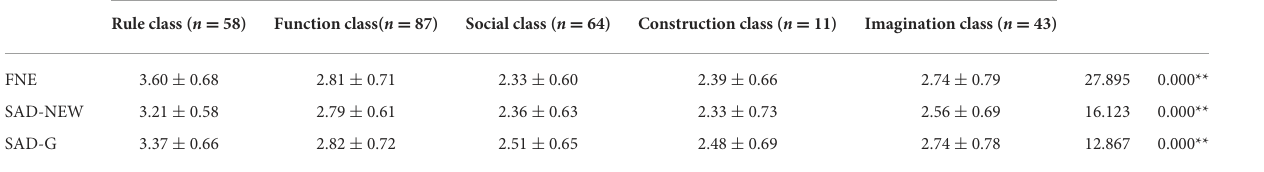
TABLE 7 Correlation results of social anxiety and children’s